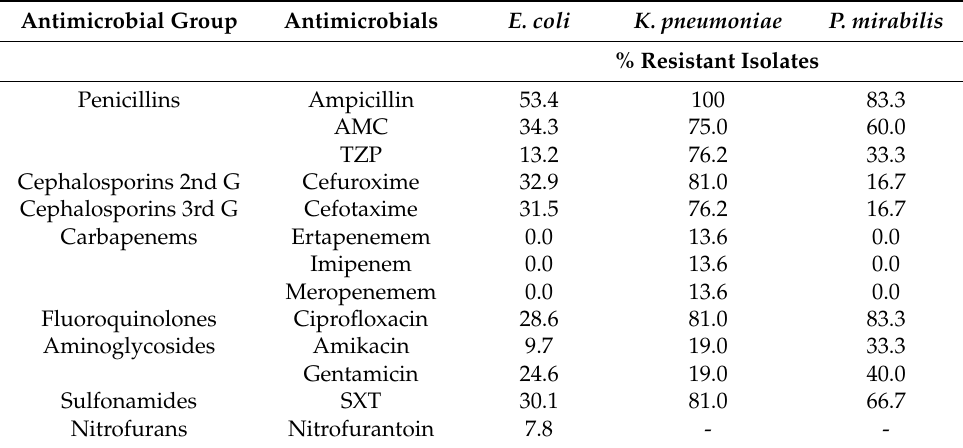
Table 6. Antimicrobial resistance of Gram-negative bacteria isolated from urine culture of hospitalized patients from January to June 2020.